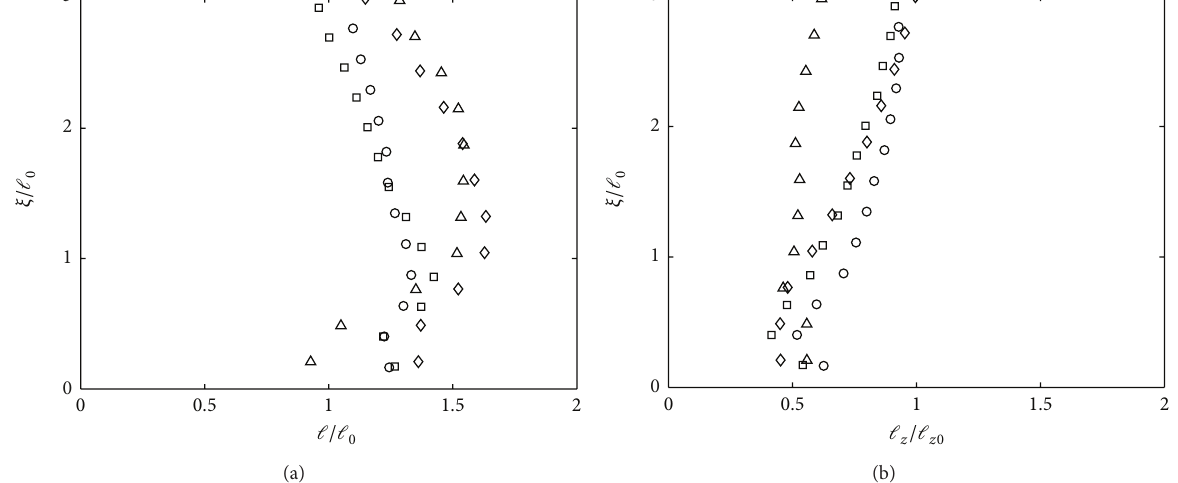
= 95 ( ∘ ), 𝑅𝑒 = 76 ( ◻ ), 𝑅𝑒 = 74 ( 󳵻 ), and 𝑅𝑒 = 113 ( ⬦ 𝑙 𝑙 𝑙 𝑙